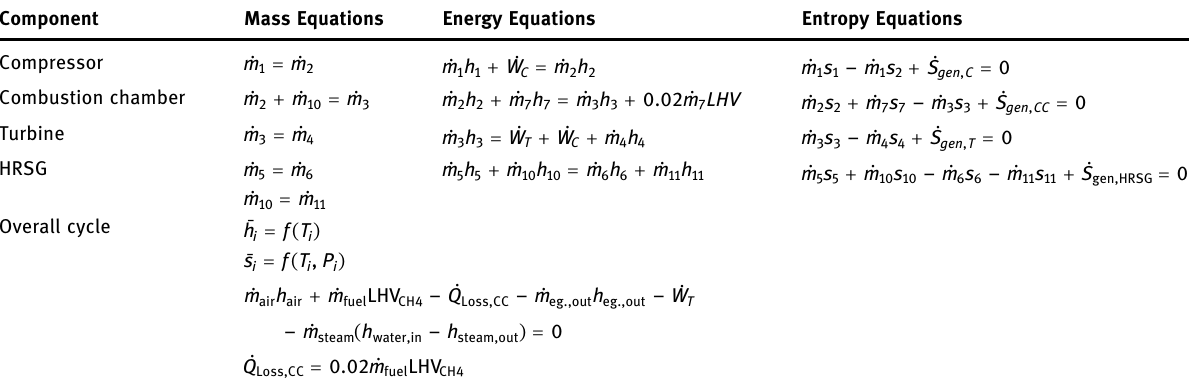
Table 1: The mass, the energy, and the entropy equations of the components of the absorption cooling cycle ( ab ) [ 8 – 10 ]